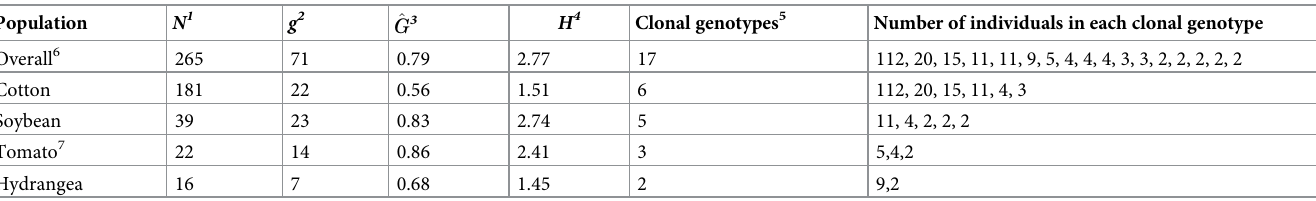
Table 3. Genotypic diversity and clonal composition of Corynespora cassiicola populations in the southeastern U.S. based on the host of origin.